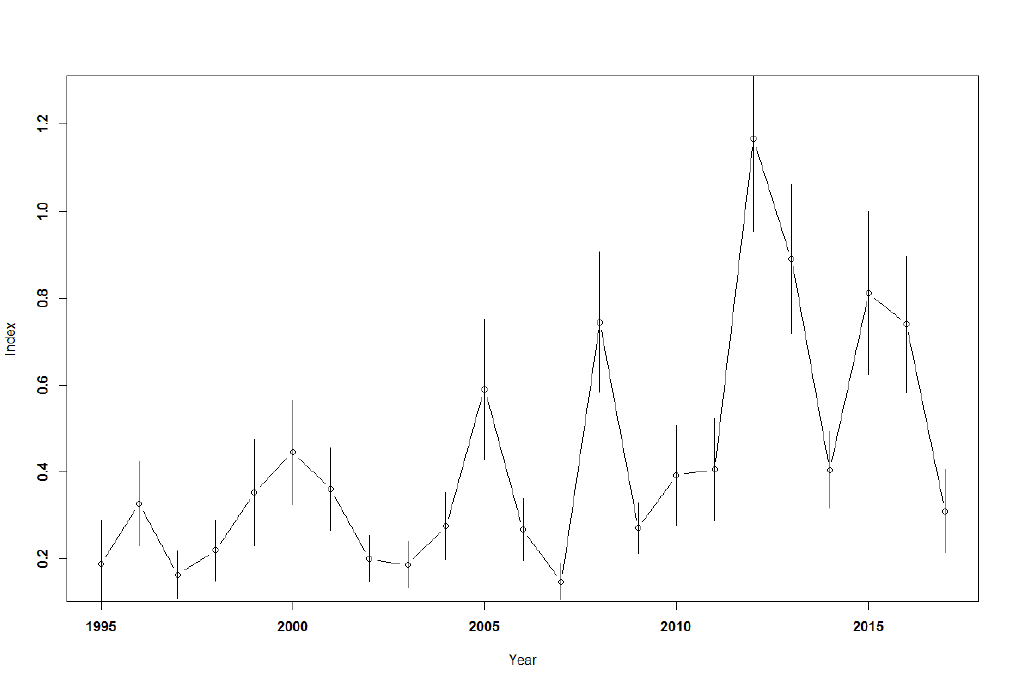
Figure 67. Index of relative abundance of horseshoe crab (delta mean catch per tow) developed from the spring portion of South Carolina’s Trammel Net Survey with 95% confidence